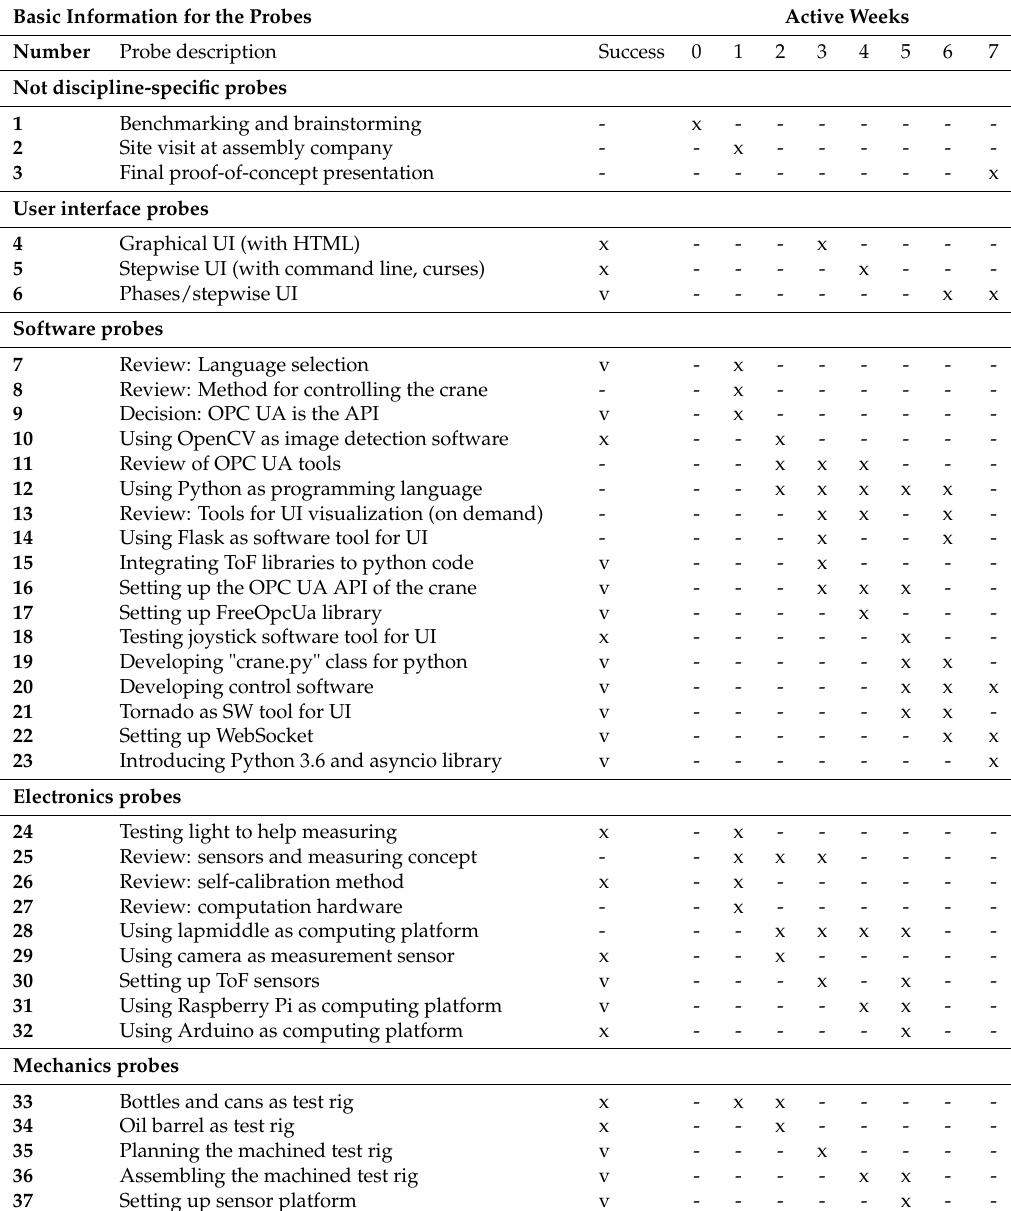
Table 1. List of probes that were